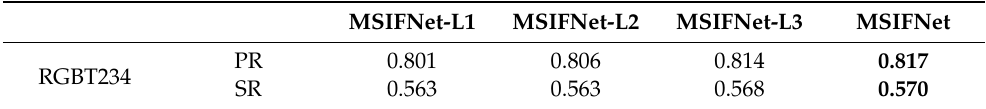
Table 4. The PR/SR scores of our method were compared with variants on the RGBT234 datasets to verify the validity of the multi-scale features extracted from each